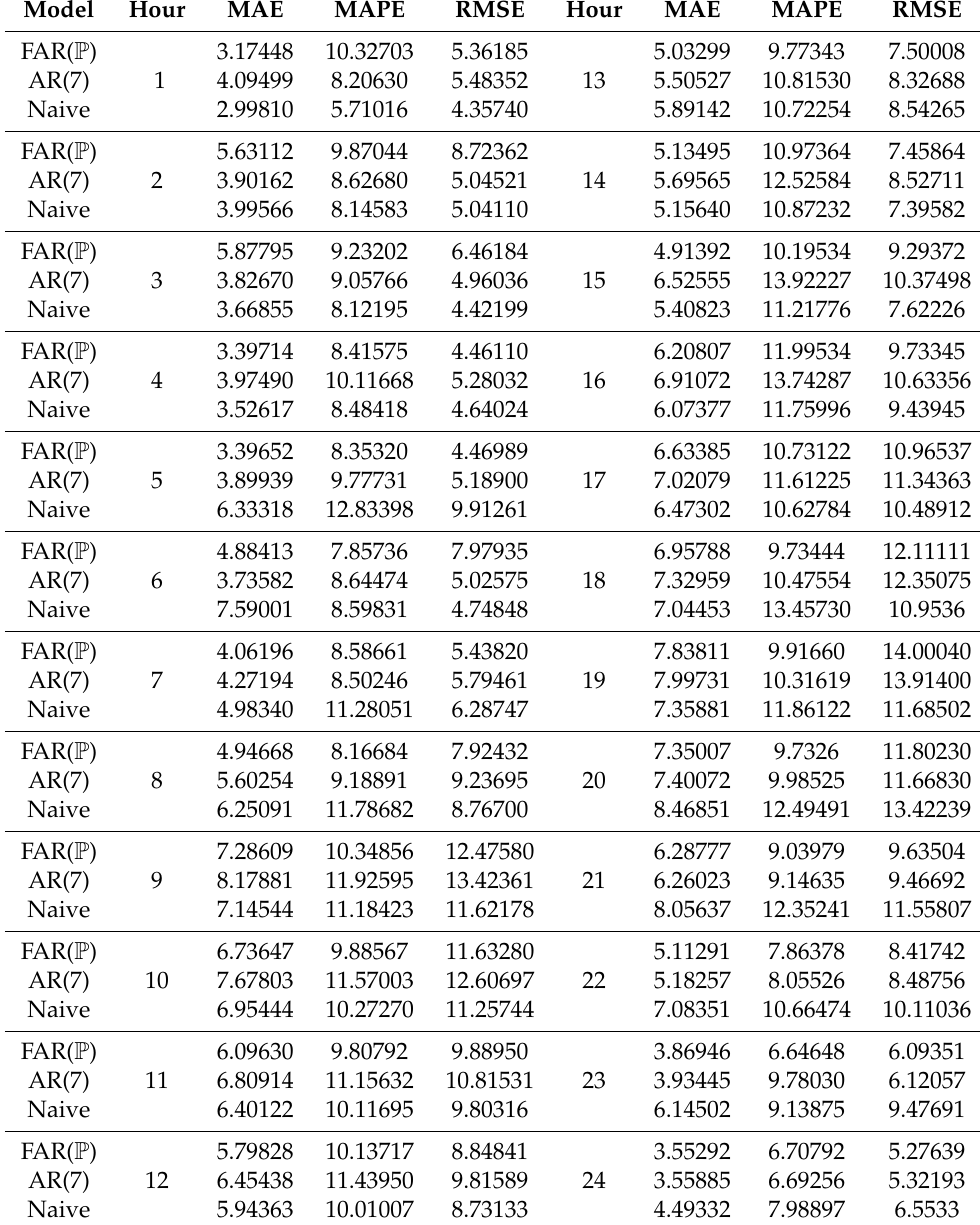
Table 3. IPEX electricity prices: hourly forecast errors for FAR( P ), AR(7), and naïve models.